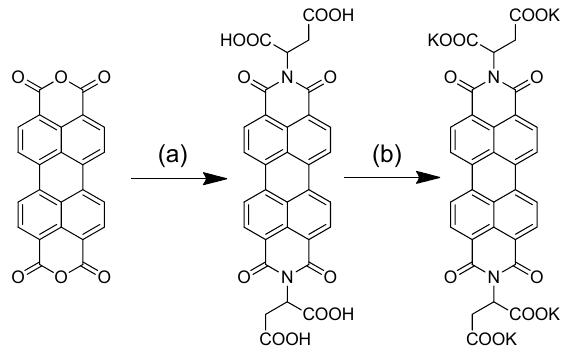
Scheme 1. Synthesis pathway of APBI-K. ( a ) DL-Aspartic Acid, imidazole, N 2 atm., 6 h, 120 ◦ C. ( b ) KOH (excess), H 2